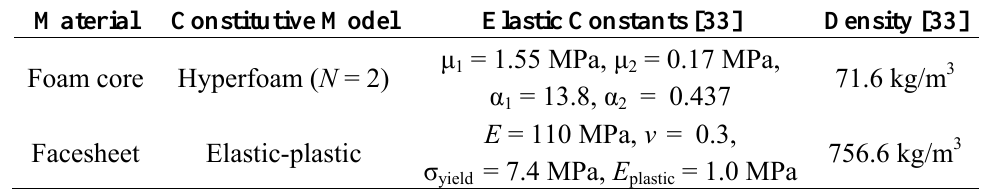
Table 1. Mechanical properties of the facesheet and core materials utilized in FE